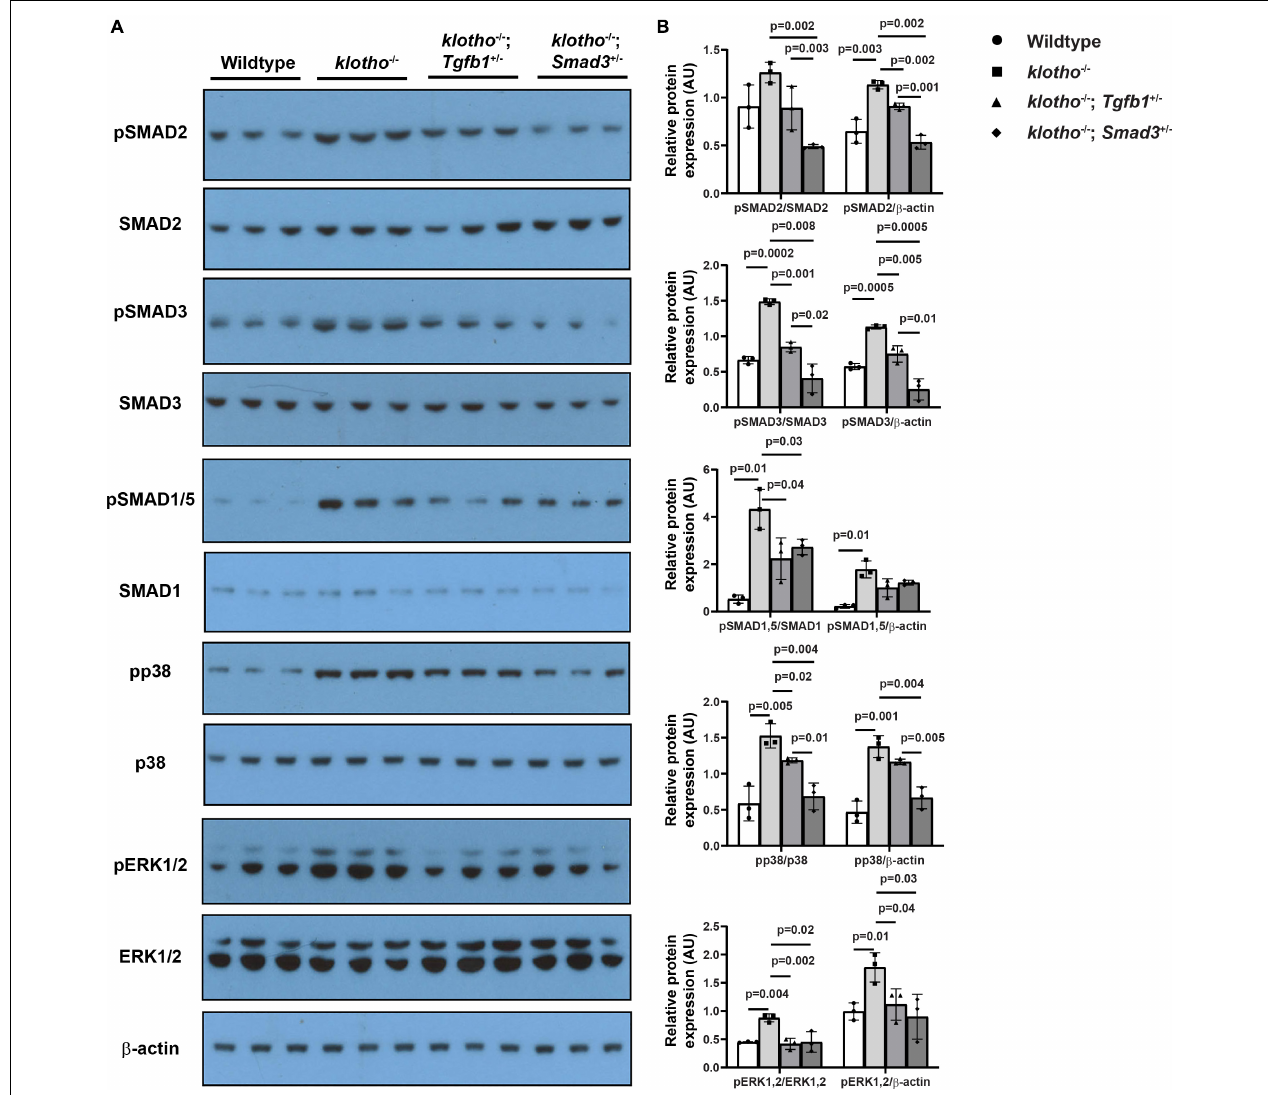
FIGURE 6 | Haploinsufficiency of Tgfb1 and Smad3 inhibits canonical and non-canonical TGF β signaling in the aortic valve of Kl − / − mice. (A) Western blot analysis on three different micro-dissected pooled tissues, from two to three hearts/sample, representing AV leaflets and hinge area and aortic annulus of 10–12-week-old wild-type, Kl − / − , Kl − / − ;Tgfb1 ± , and Kl − / − ;Smad3 ± mice showing protein levels of the phosphorylated forms of canonical and non-canonical pathway molecules (pSMAD2, pSMAD3, pSMAD1/5, pp38, and pERK1/2) and their non-phosphorylated/total forms (SMAD2, SMAD3, SMAD1/5, p38, and ERK1/2). A common and independent β -actin blot (bottom) was also used for normalizing the data. (B) Densitometric quantification of phosphorylated proteins after normalization to total non-phosphorylated proteins or β -actin. Numerical data (mean ± SD ) from three pooled samples are presented as scatter plots with bar. The p -values are shown on top of the histograms.